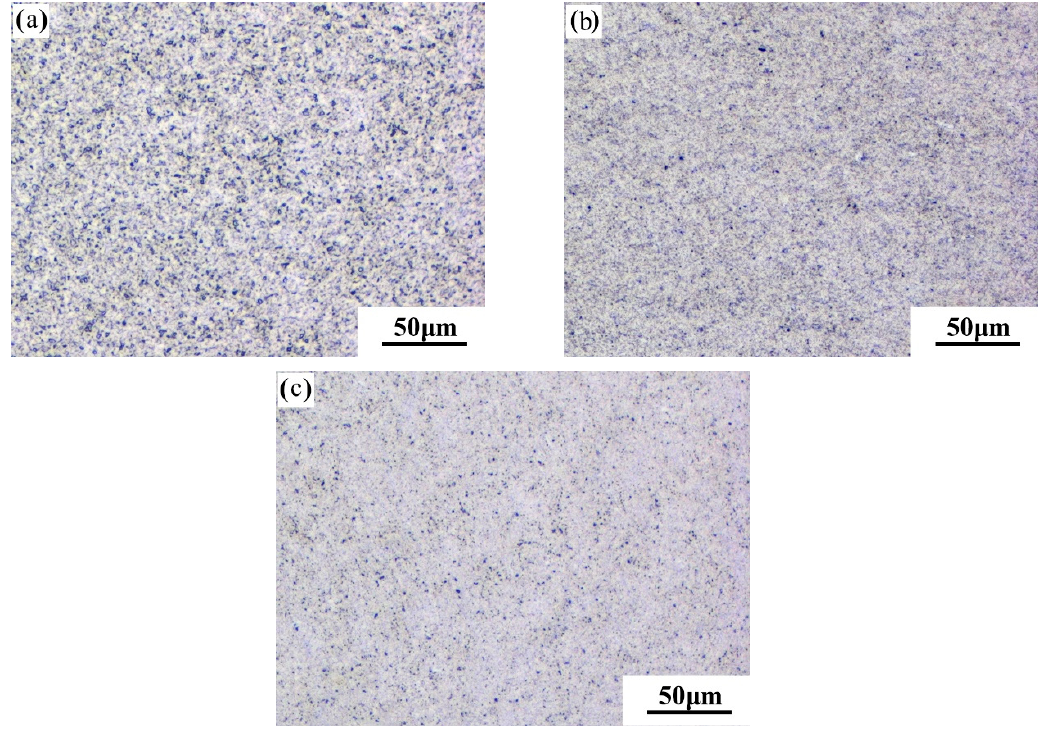
Figure 4. OM images of CP Ti after MDF with ( a ) 1 cycle ( b ) 2 cycles ( c ) 3 cycles.